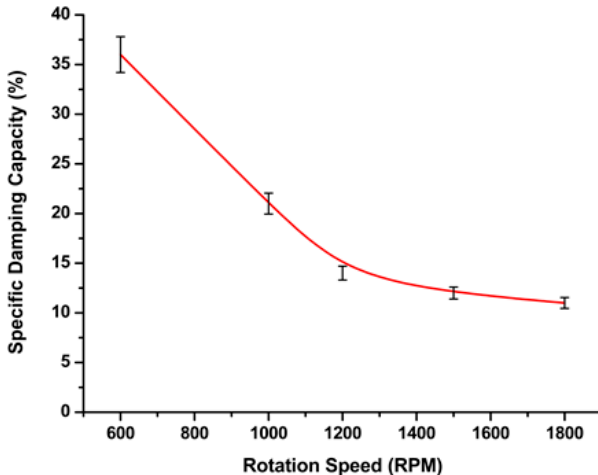
Figure 5. Reciprocal fit of specific damping ratio and tool rotation speed at a constant welding speed of 32 mm/min.